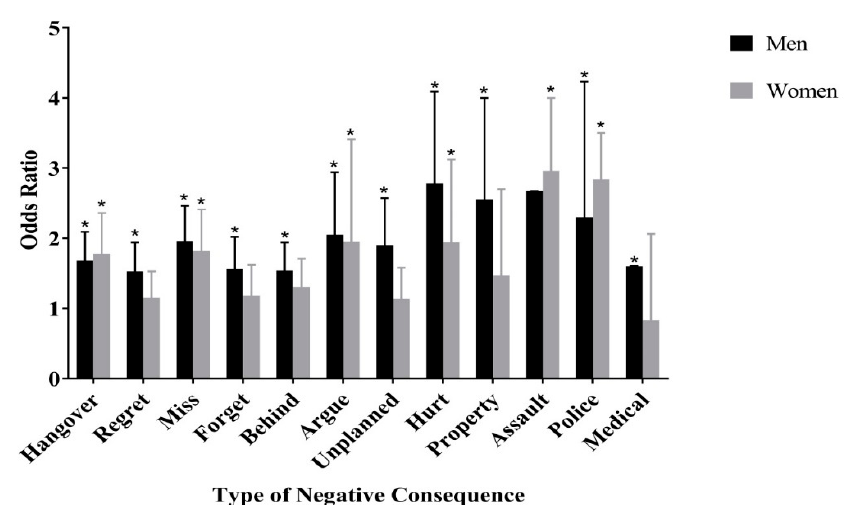
Figure 1. Odds of negative alcohol-related consequences according to AmED use by sex (controlled for alcohol consumption frequency, number of drinks per drinking session, year level, major, grade point average (GPA), spending allowance, smoking status, stress level, depressive thoughts, suicidal thoughts, suicidal attempt, underage drinking experience, and number of clubs/organizations).